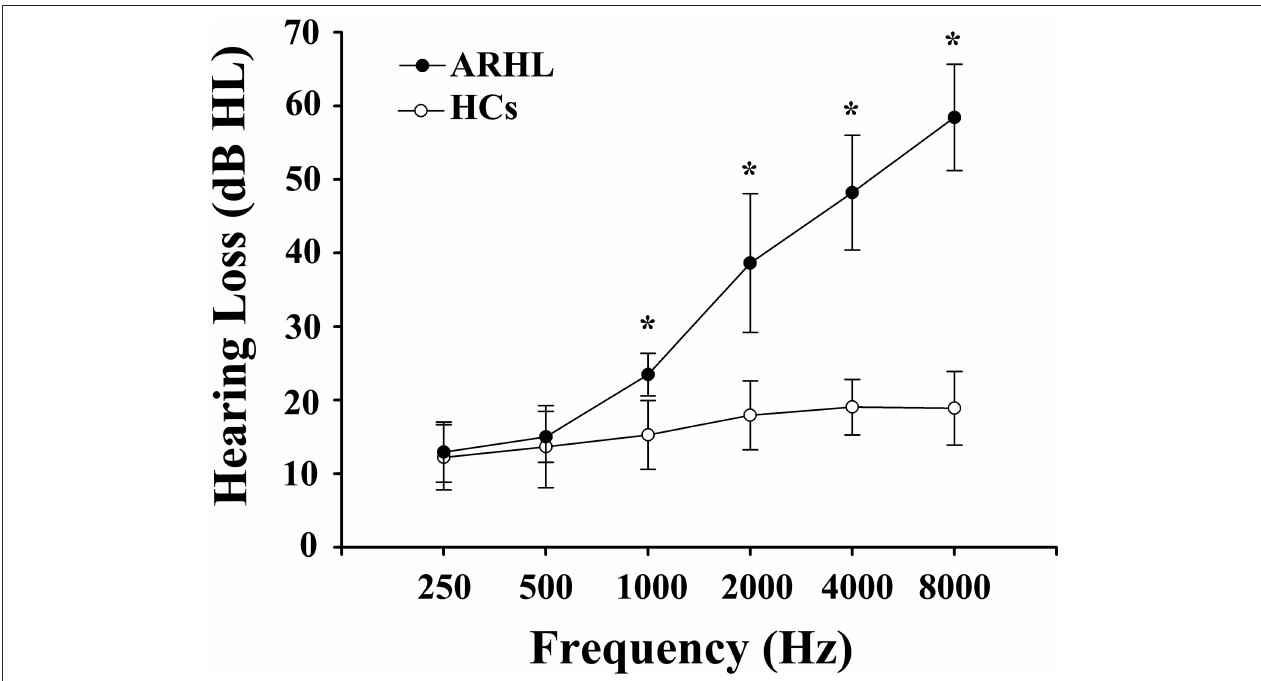
FIGURE 1 | Mean hearing thresholds of age-related hearing loss (ARHL) patients and healthy controls (HCs). The hearing thresholds were significantly higher in ARHL than HCs (* p < 0.001, 1,000–8,000Hz). Data are presented as mean ± SD.